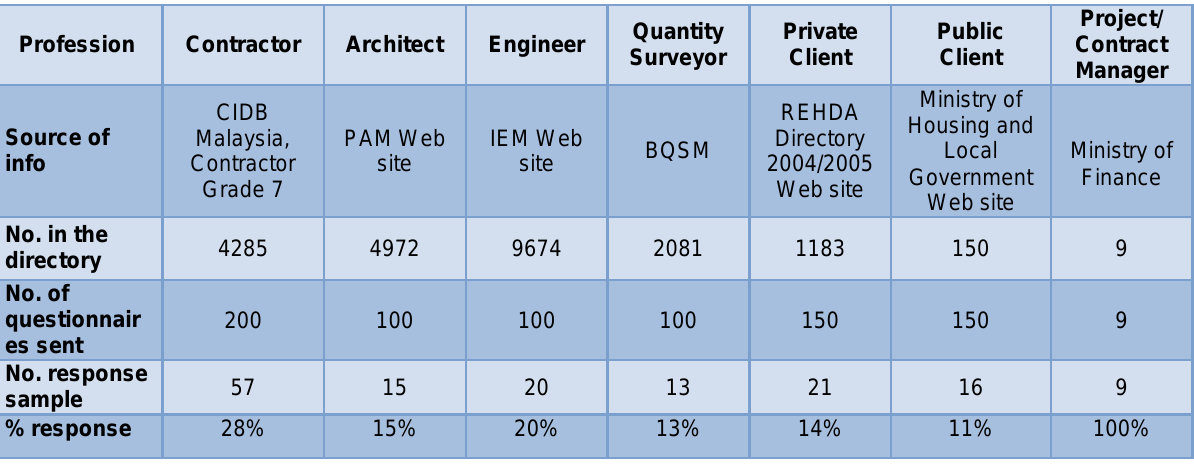
Table 1 Response rate by